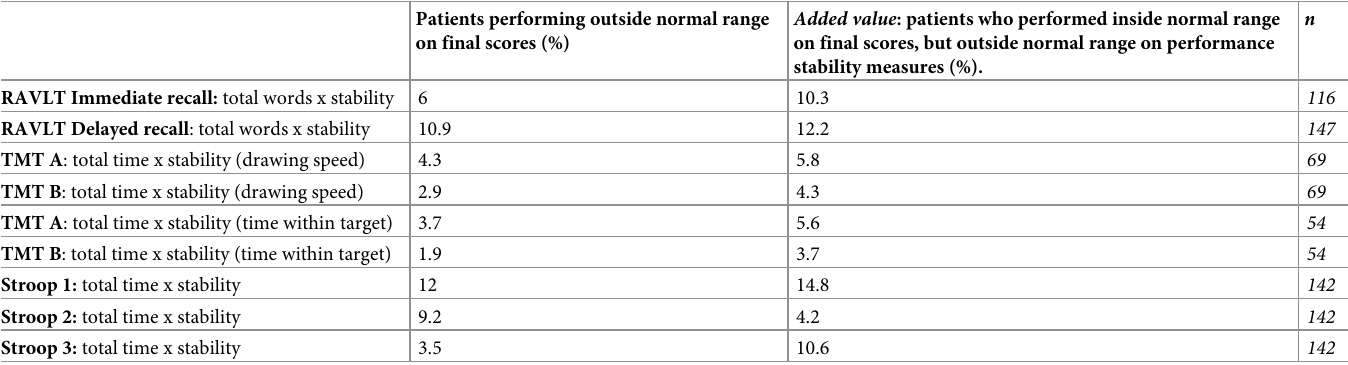
Table 2. Percentages of patients outside normal range based on performance stability measures in reference to conventional final scores. Patients performing outside normal range Added value : patients who performed inside normal range on final scores (%) on final scores, but outside normal range on performance stability measures (%).